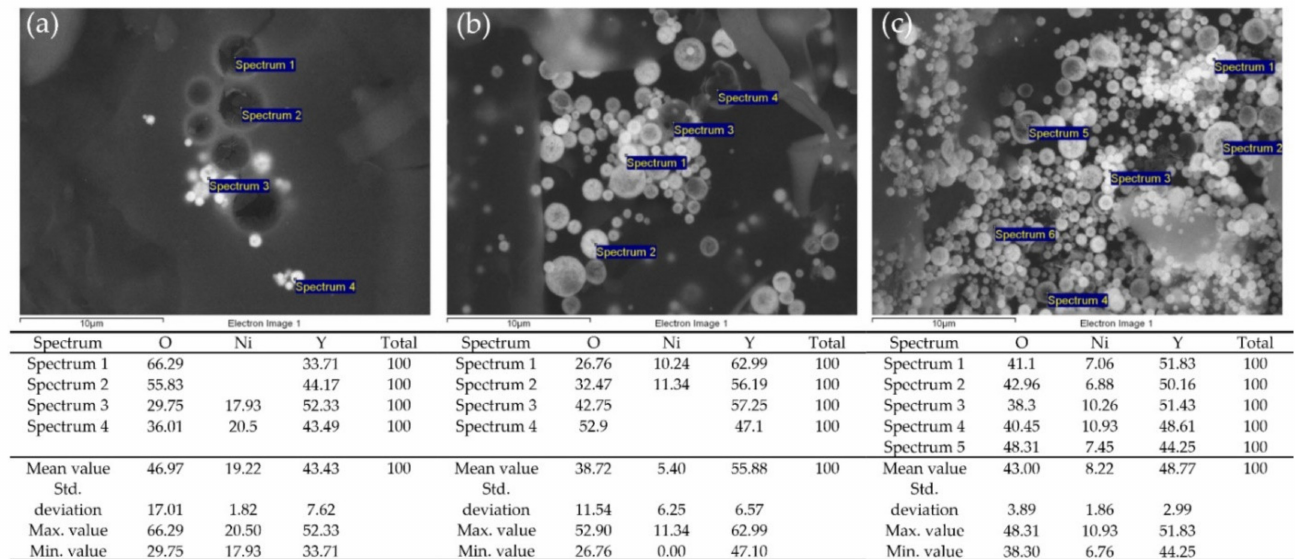
Figure 6. SEM micrographs and EDX analysis of the powder: ( a ) Ni/Y 2 O 3 -0.100/0.200, ( b ) Ni/Y 2 O 3 - 0.050/0.200, and ( c ) Ni/Y 2 O 3